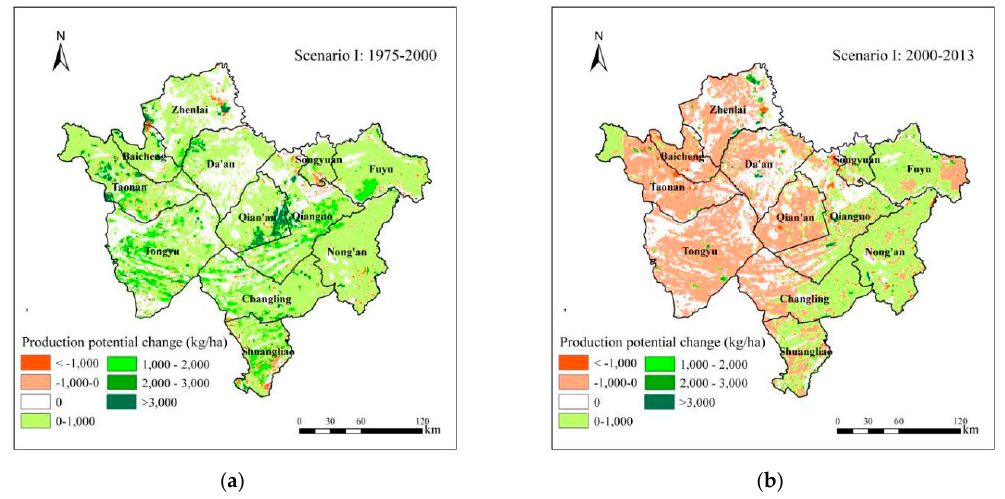
Figure 8. Spatial distribution of soybean production potential change between 1975 and 2000, and between 2000 and 2013 under Scenario I. ( a ) between 1975 and 2000; ( b ) between 2000 and